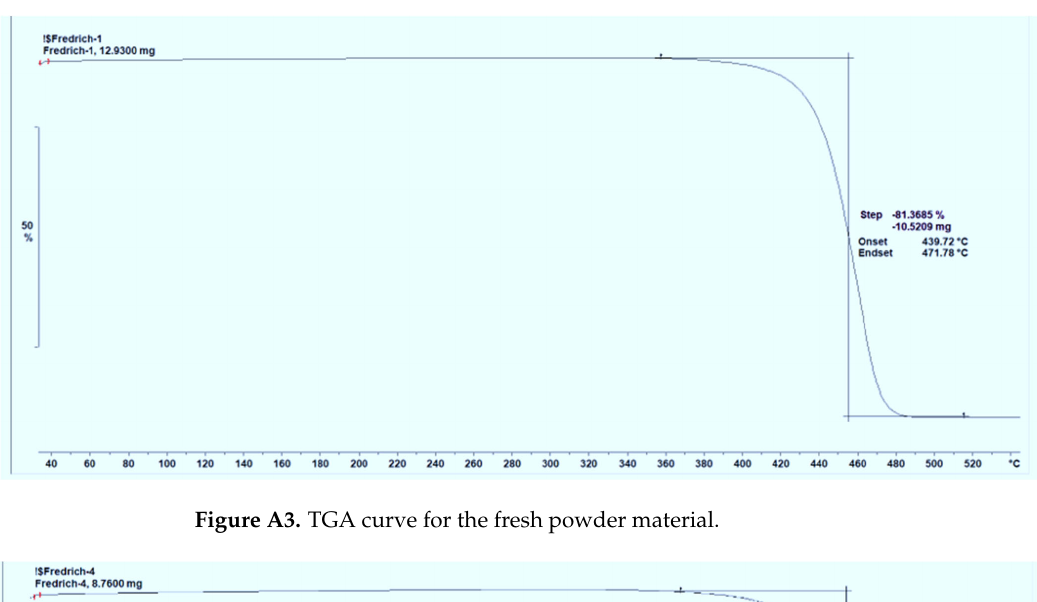
Figure A2. DSC curve of the powder after the 9th print cycle.